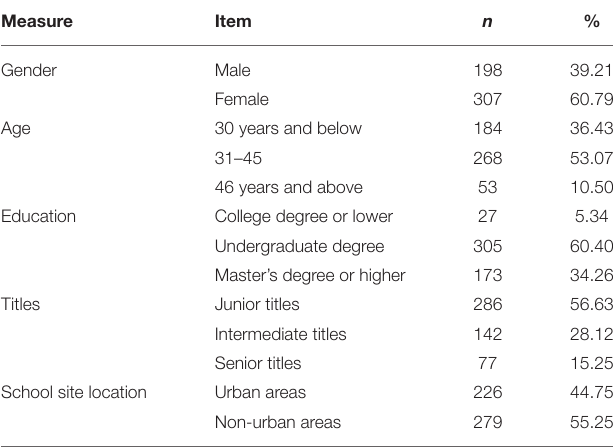
TABLE 1 | Demographic information of sample ( N =